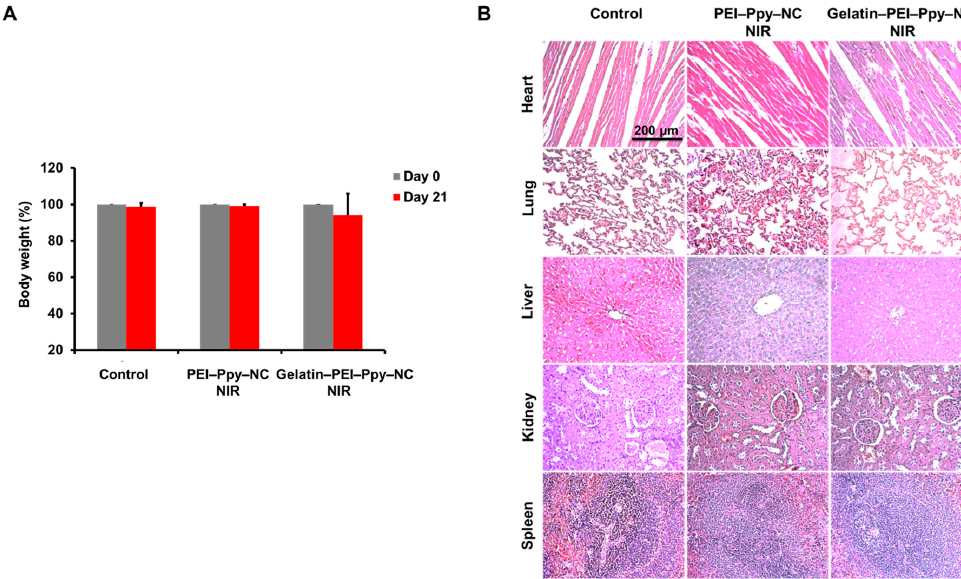
Figure 10. ( A ) Comparative body weight change (%) between day 0 and day 21 of the experiment in the control and experimental groups; ( B ) Histological findings of primary organs from the control and experimental Wistar rat groups’ heart, lung, liver, kidney, and spleen tissue.